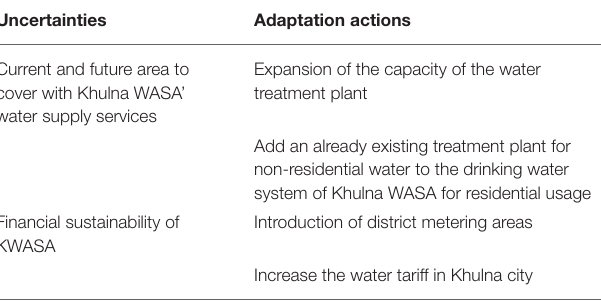
TABLE 3 | Results of interviews with local key informants: uncertainties and adaptation